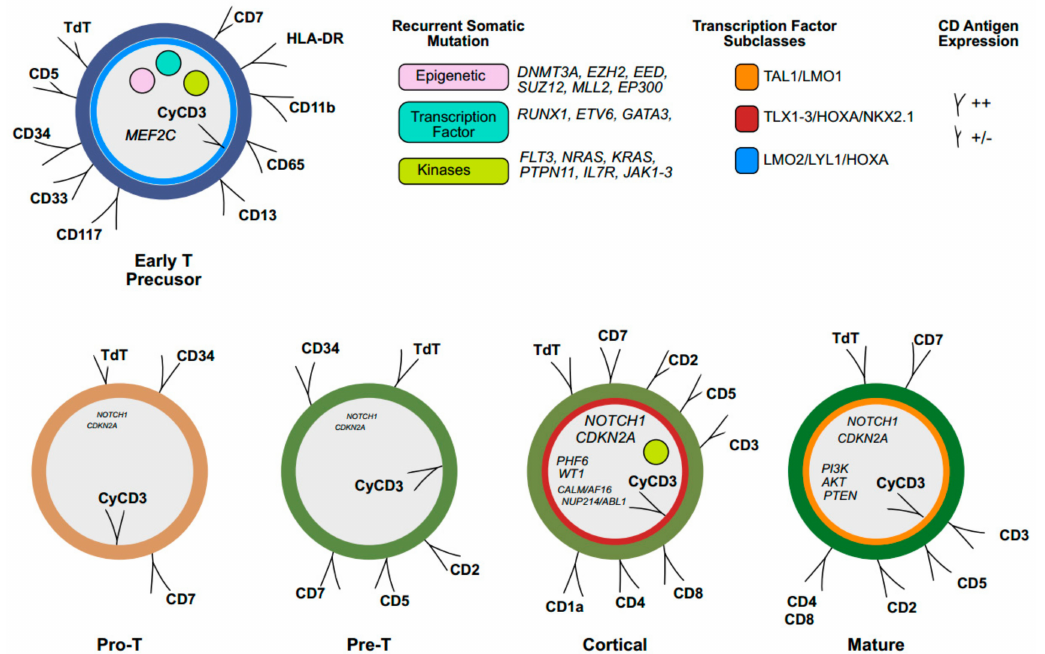
Figure 1. Immunophenotypic and molecular signatures of T-cell acute lymphoblastic leukemia